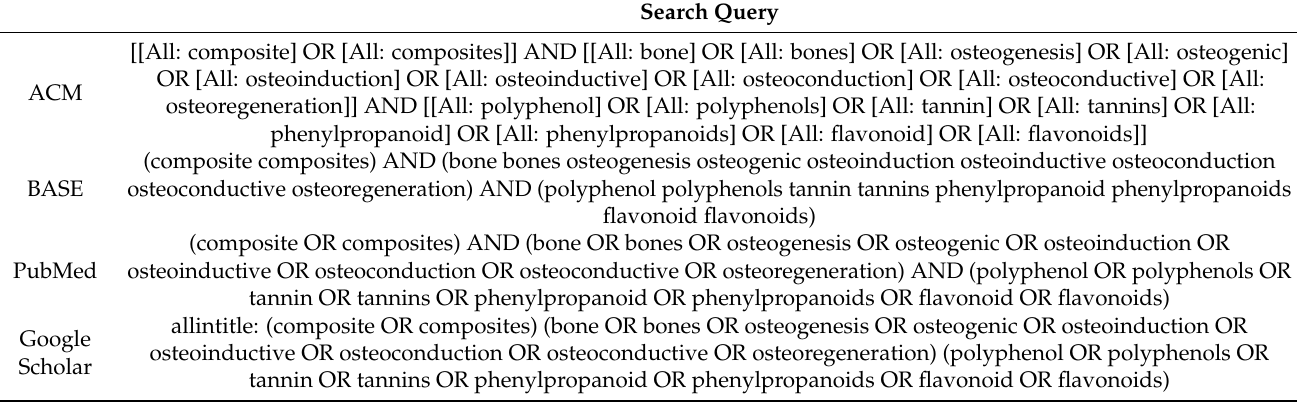
Table A1. Search queries.